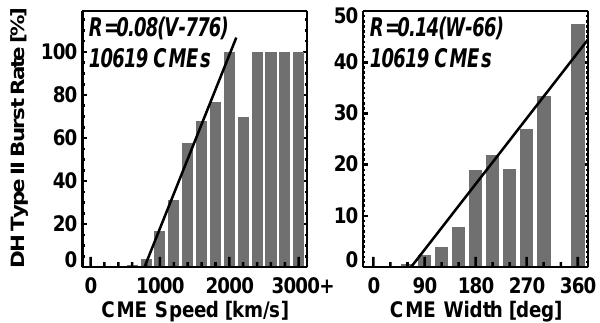
Fig. 6. Association rate (R) of DH type II burst as a function of CME speed (V) and width (W). The regression lines and their equa- tions are shown on the plots. All the 10619 CMEs observed from 1996 to 2005 are considered. The rate is below 5% for 800km/s CMEs and reaches 100% for 2000km/s and faster CMEs. The rate is significant only for CMEs wider than 60 ◦ and reaches a maxi- mum of 47% for halo CMEs. The rate is less than 50% even for full halos because of backside events and slow halos. We have not plotted the rate variation with longitude because we do not have the heliographic coordinates for all the CMEs. The lower rate in the 2200 km/s bin is discussed in the